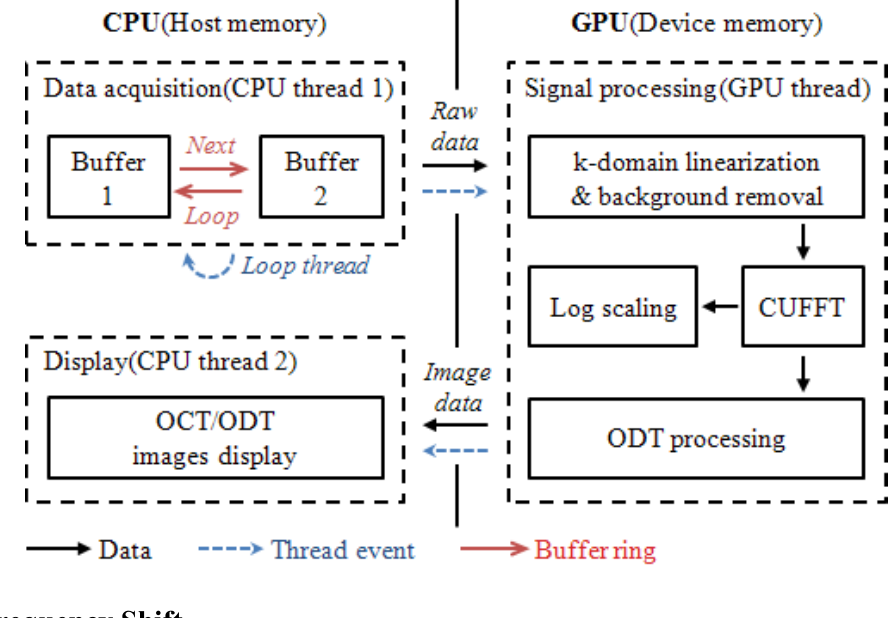
Figure 2. Architecture of the SD-ODT system with signal processing part implemented in a